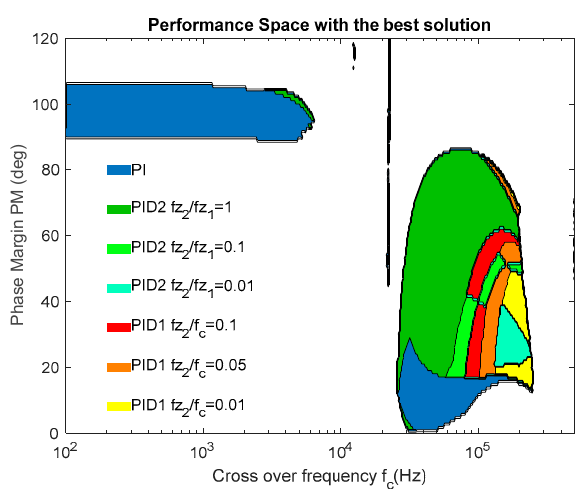
Figure 11. Performance space considering seven different compensators and selecting the best possible solution among them for each point of the performance space ( f c , PM ).